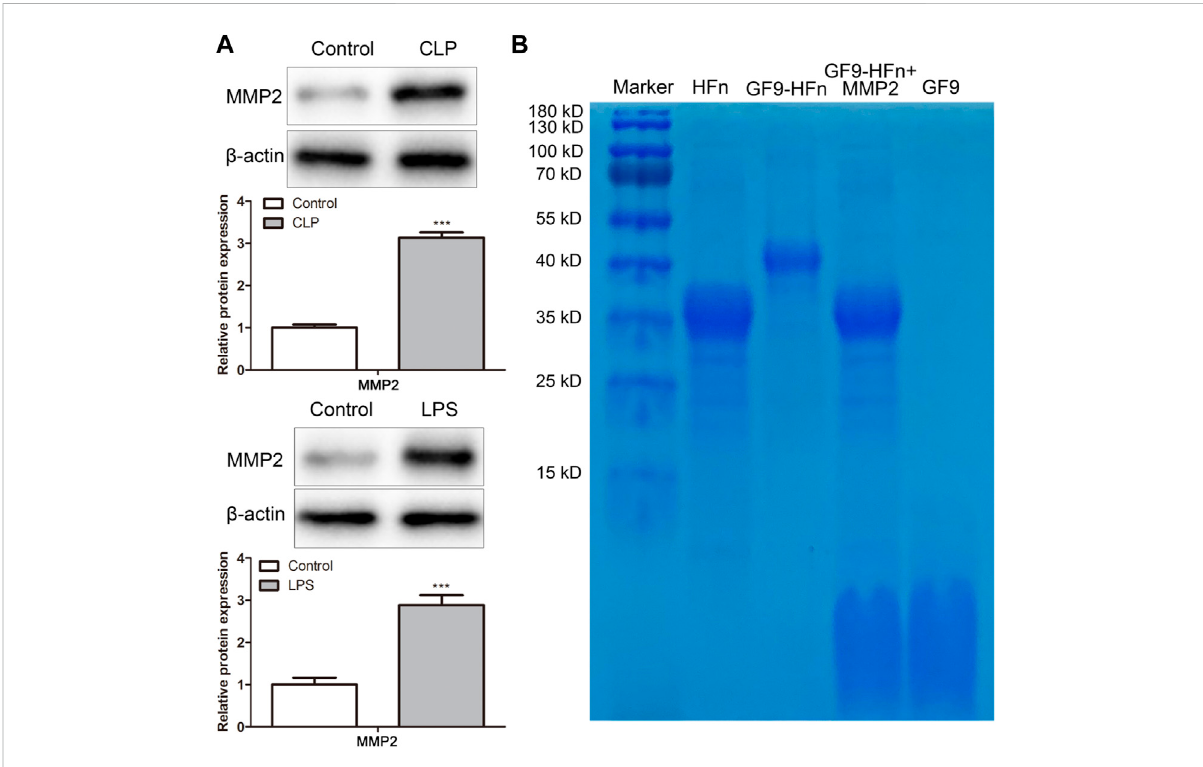
FIGURE 2 GF9 can be released by MMP2. (A) The protein expression level of MMP2 was assessed in vivo and in vitro . (B) The size of nanomedicines was assessed by western blot. MMP2, matrix metalloproteinase-2. *** p < 0.001 vs . Control.